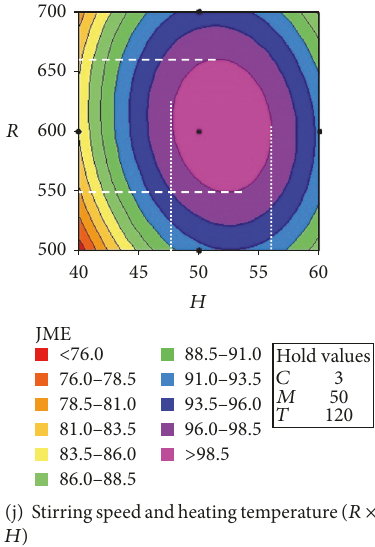
Figure 8: Contour plots showing transesterification parametric interactions impact on JME yield.